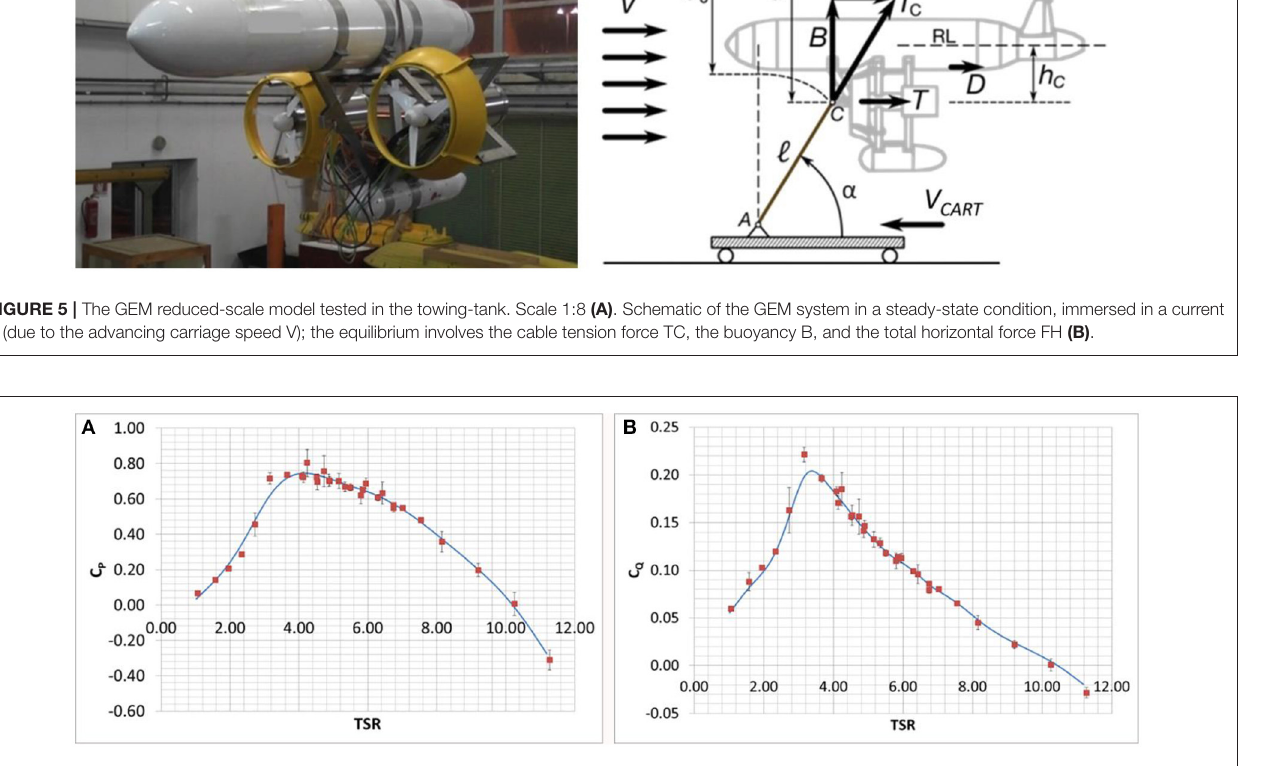
FIGURE 6 | Measured power coefficient averaged values. Turbines with shrouds, V = 1.5 m/s (A) . Measured torque coefficient averaged values. Turbines with shrouds, V = 1.5 m/s (B)